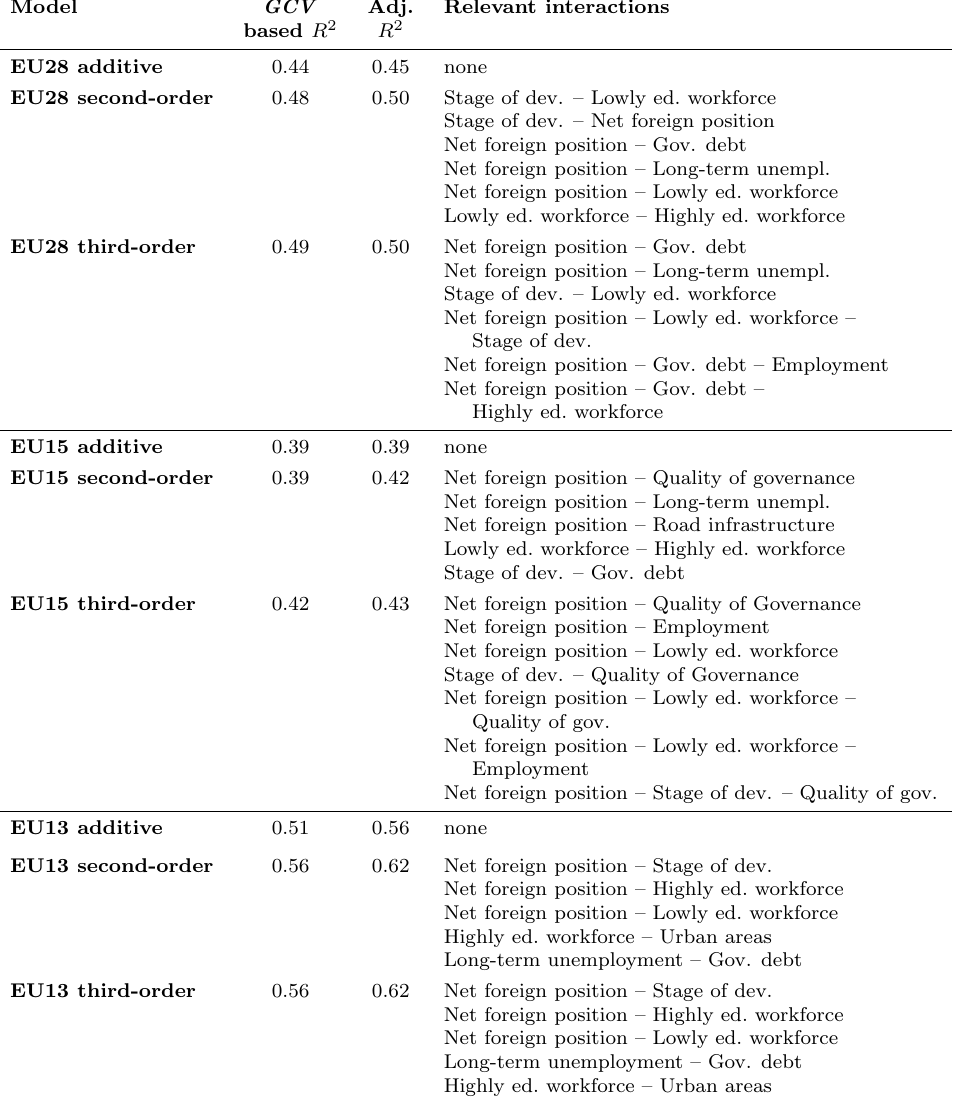
Table 4: Comparison of different MARS models and their interacting factors